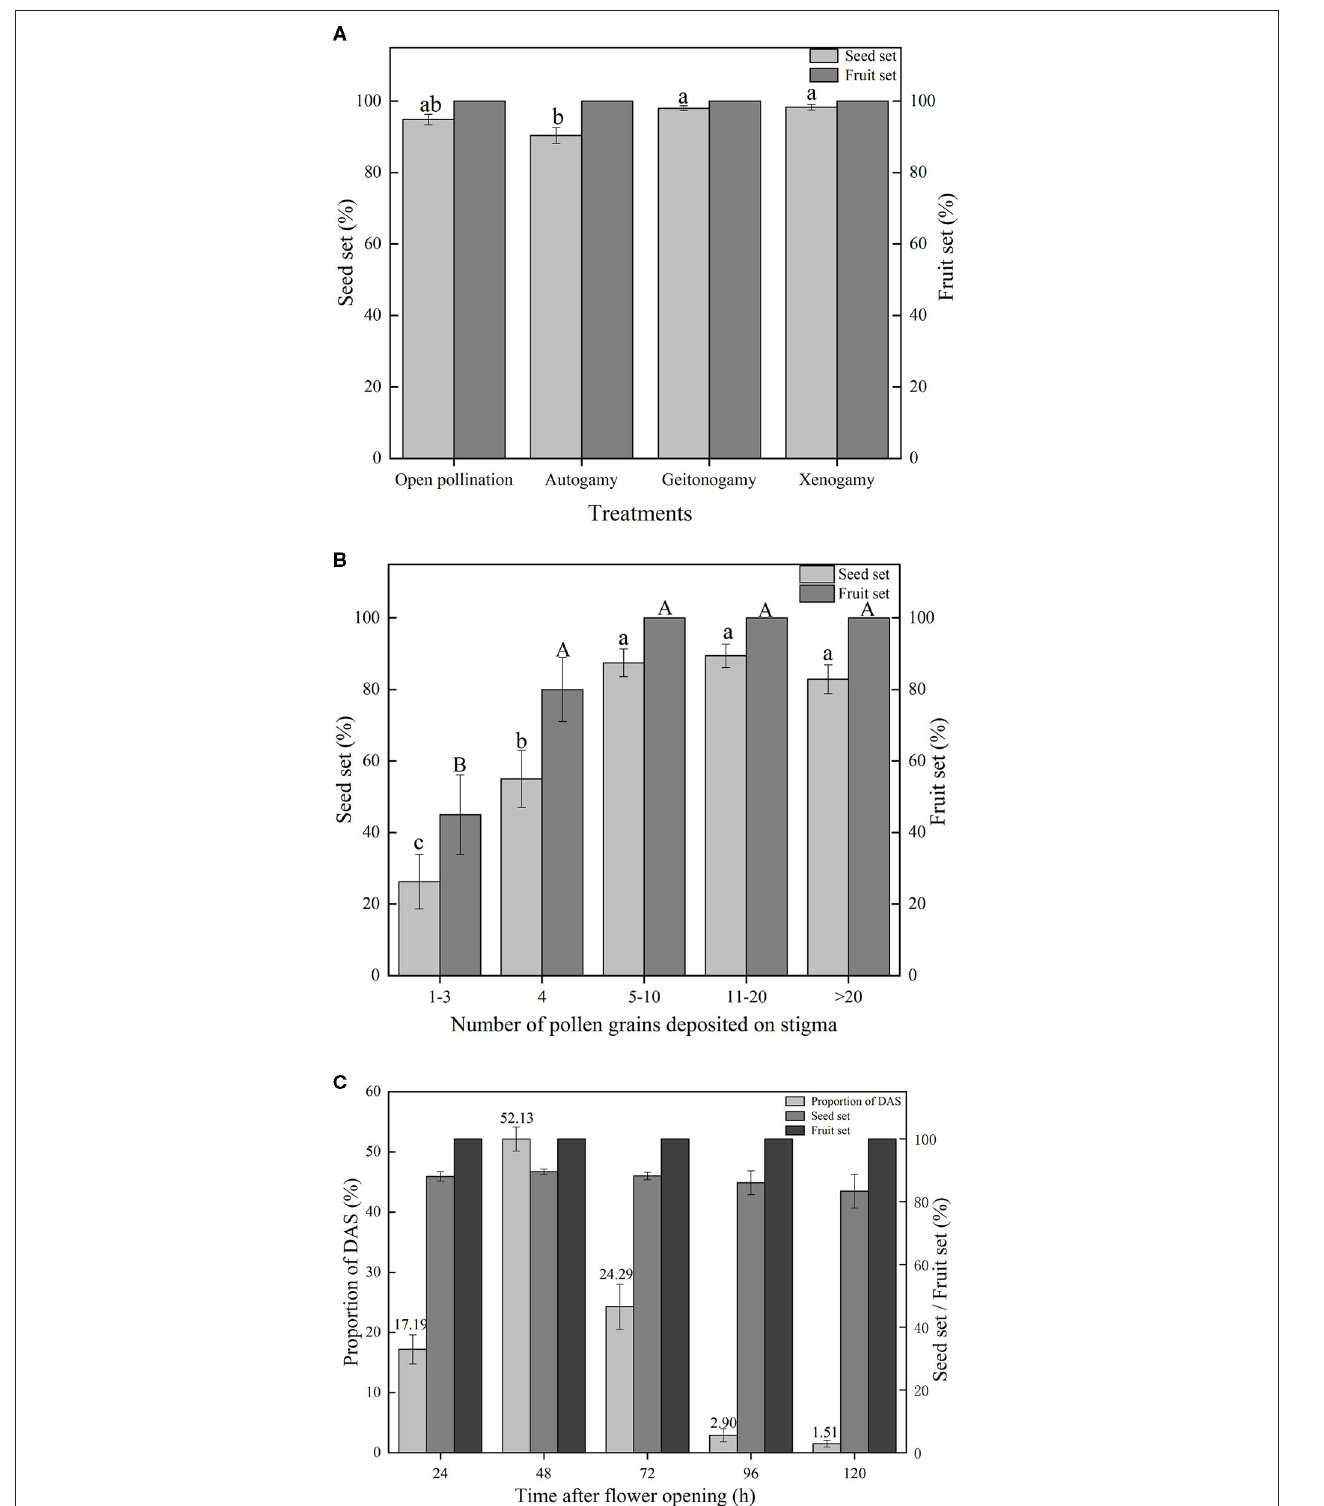
FIGURE 4 | (A) Mean fruit set and seed set of flowers subjected to different pollination treatments (bars indicate standard errors). Treatments sharing the same letters placed above bars are not significantly different according to Tukey’s test. N.B. Autogamy, Geitonogamy, and Xenogamy refer to treatments where seed was produced after autonomous selfing, hand-pollination with pollen from same plant, and hand-pollination with pollen from a different plant, respectively. (B) Mean fruit set and seed